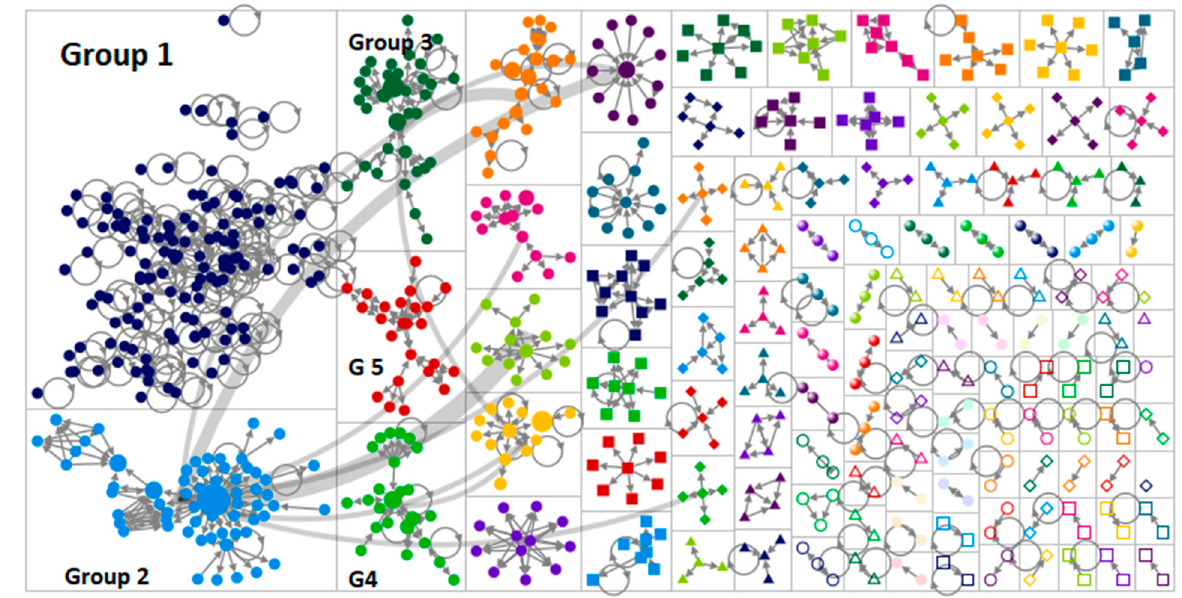
Figure 1. Represents a visualization of melanoma on